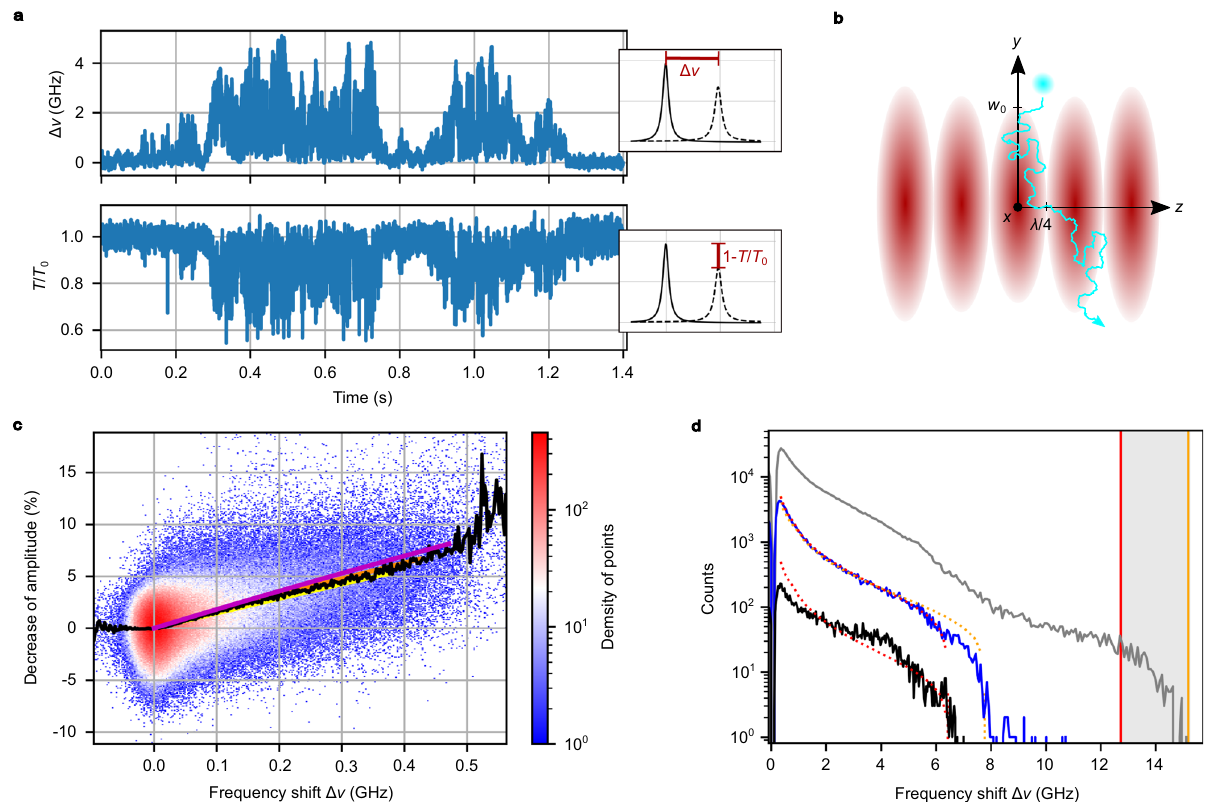
Fig. 2 Quantitative nanoparticle characterization. a Cavity frequency shift Δ ν and peak transmission amplitude T / T 0 as a function of time produced by a single SiO 2 nanoparticle. b Schematic sketch of a single nanoparticle diffusing through the standing wave cavity fi eld. c Correlation of cavity frequency shifts and transmission reductions. Solid black line: mean transmission reduction for a given frequency shift. Solid lines: simulation for the nanoparticle ’ s refractive indices n NP = {1.41, 1.42, 1.43} (yellow, orange, purple). d Histograms for the measured frequency shifts of a single transit event (black data) also shown in Fig. 3b, 59 transits (blue data, measurement duration: 2 h) and 210 additional transits (gray data, 8 h). The observed increased shifts reveal agglomeration. Dotted lines: simulation for n NP = 1.43 and the hydrodynamic radii r hydr = {77.4, 82.3} nm (red, orange). The vertical solid red and orange lines depict the corresponding estimated dimer